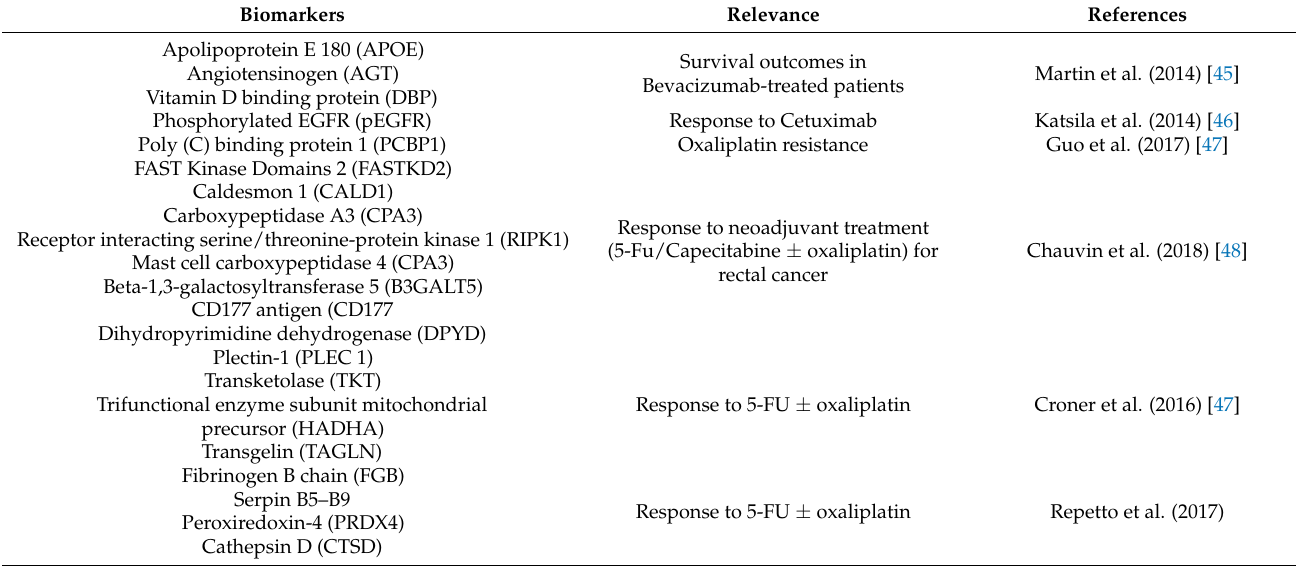
Table 2. Predictive proteomic biomarkers in clinical